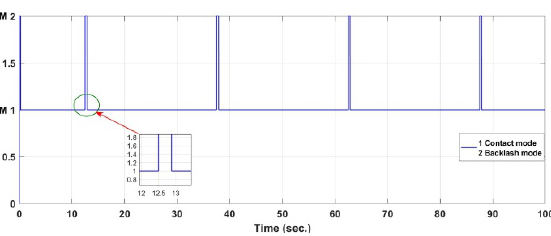
Figure 6. Sliding variables vs. time for both modes